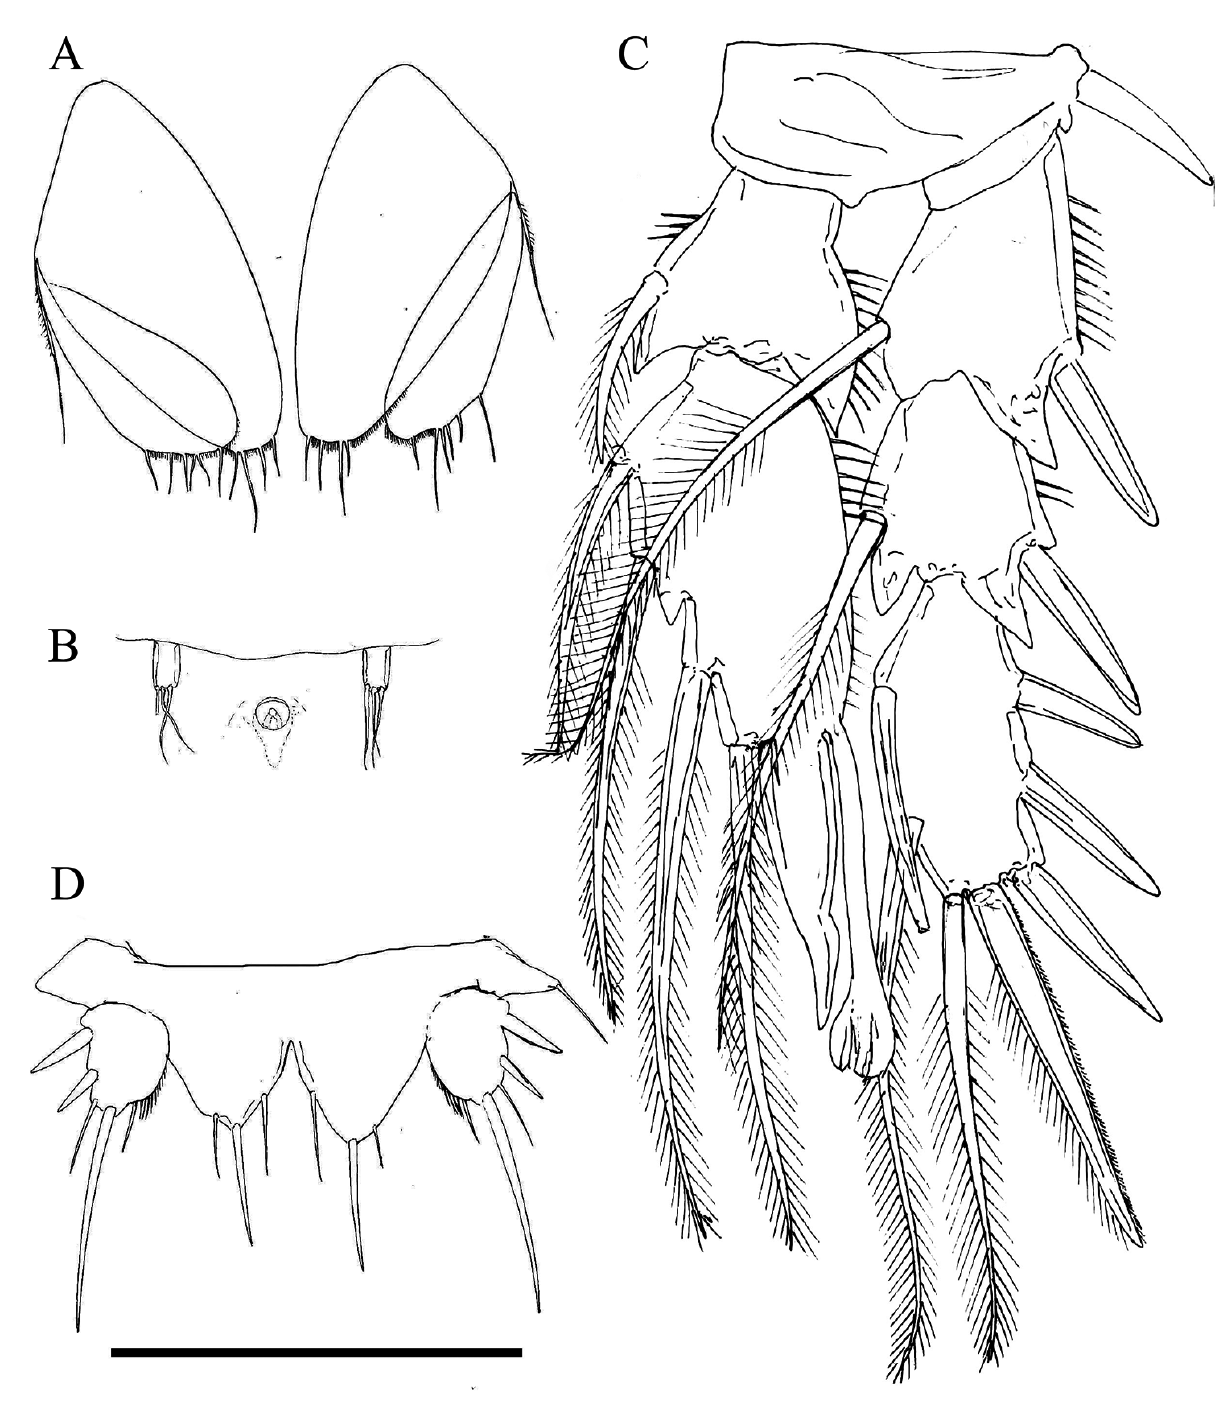
Figure 7. Eudactylopus fasciatus Sewell, 1940, female. A, P5; B, P6. Male, C, P2; D, P5. Scale bar: 100